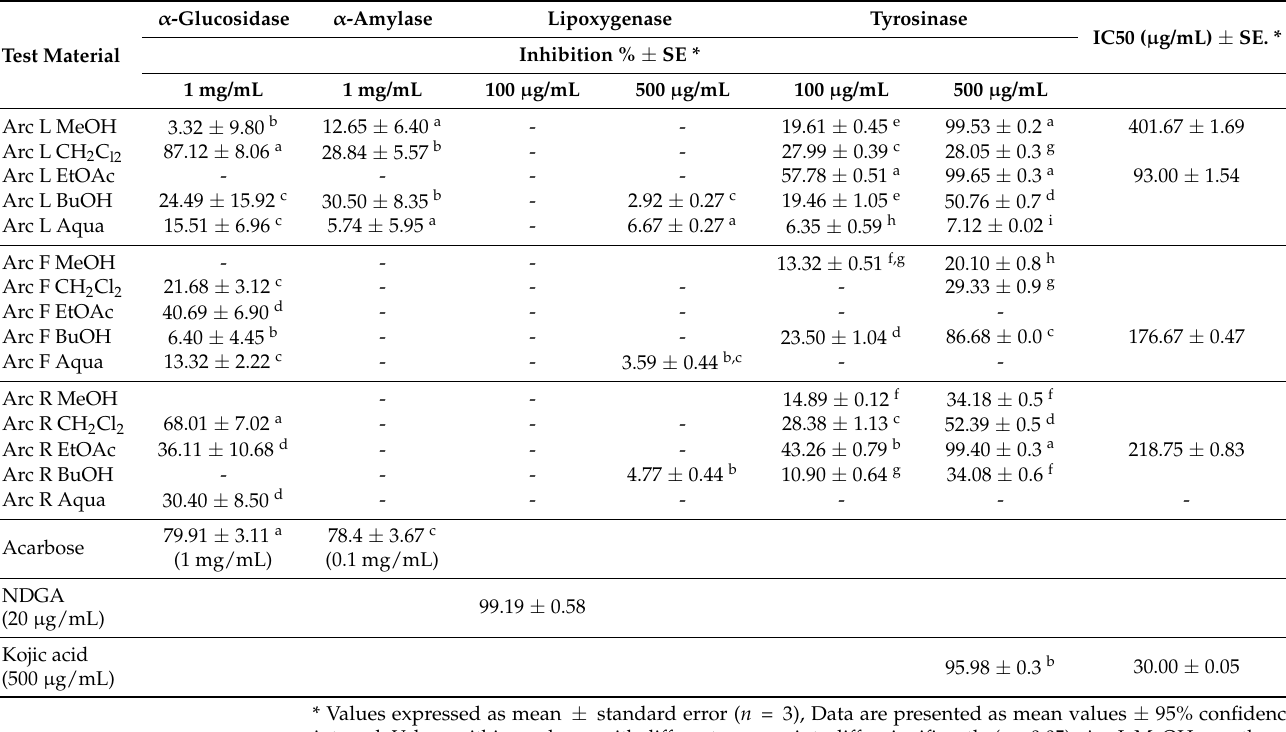
Table 6. Enzyme inhibitory activities of the extracts from A. minus